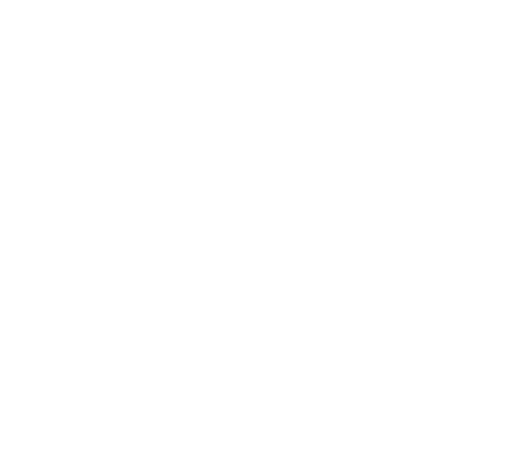
Figure 12. Original image (Hyphantria